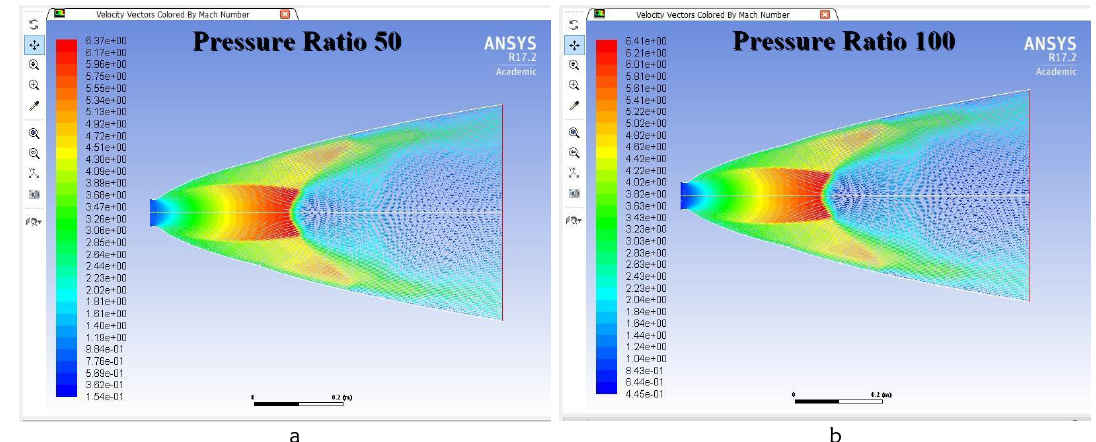
Figure 7: Contour of Mach velocity vector for pressure ratio 50 (a) and 100